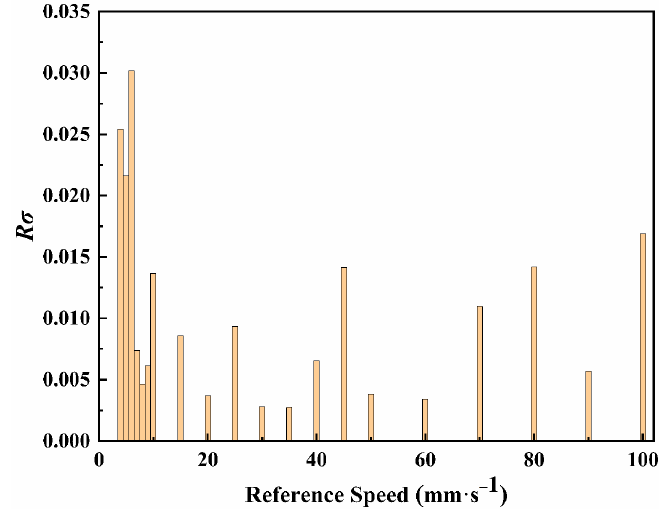
Figure 9. The relative standard deviation of three repeated measurements at each velocity.